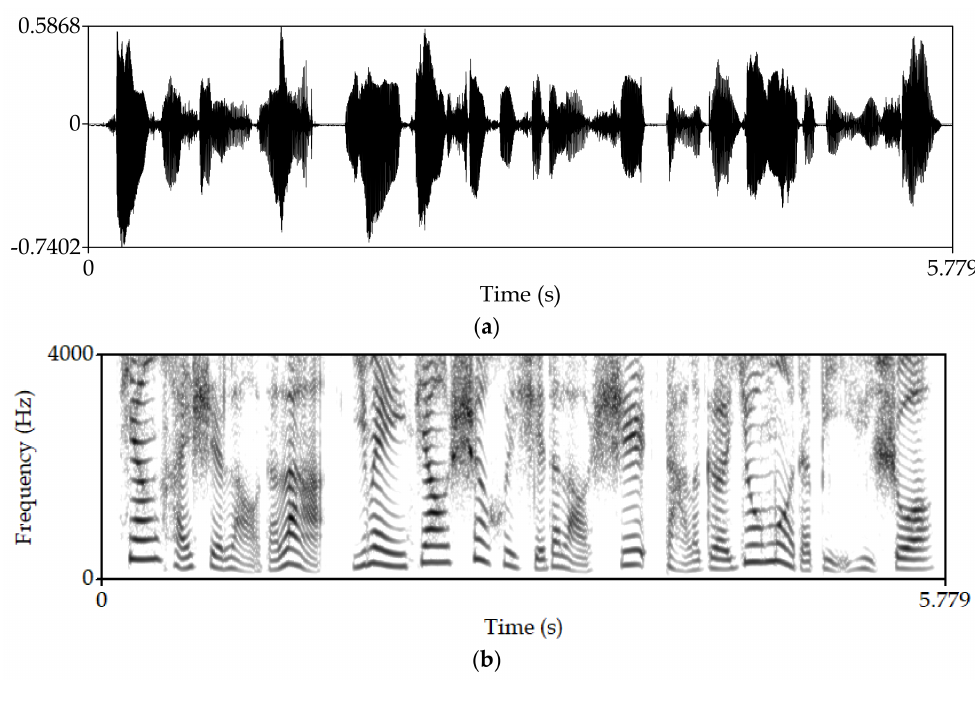
Figure 5. Watermarked speech signal ( a ) Waveform ( b ) Spectrogram.